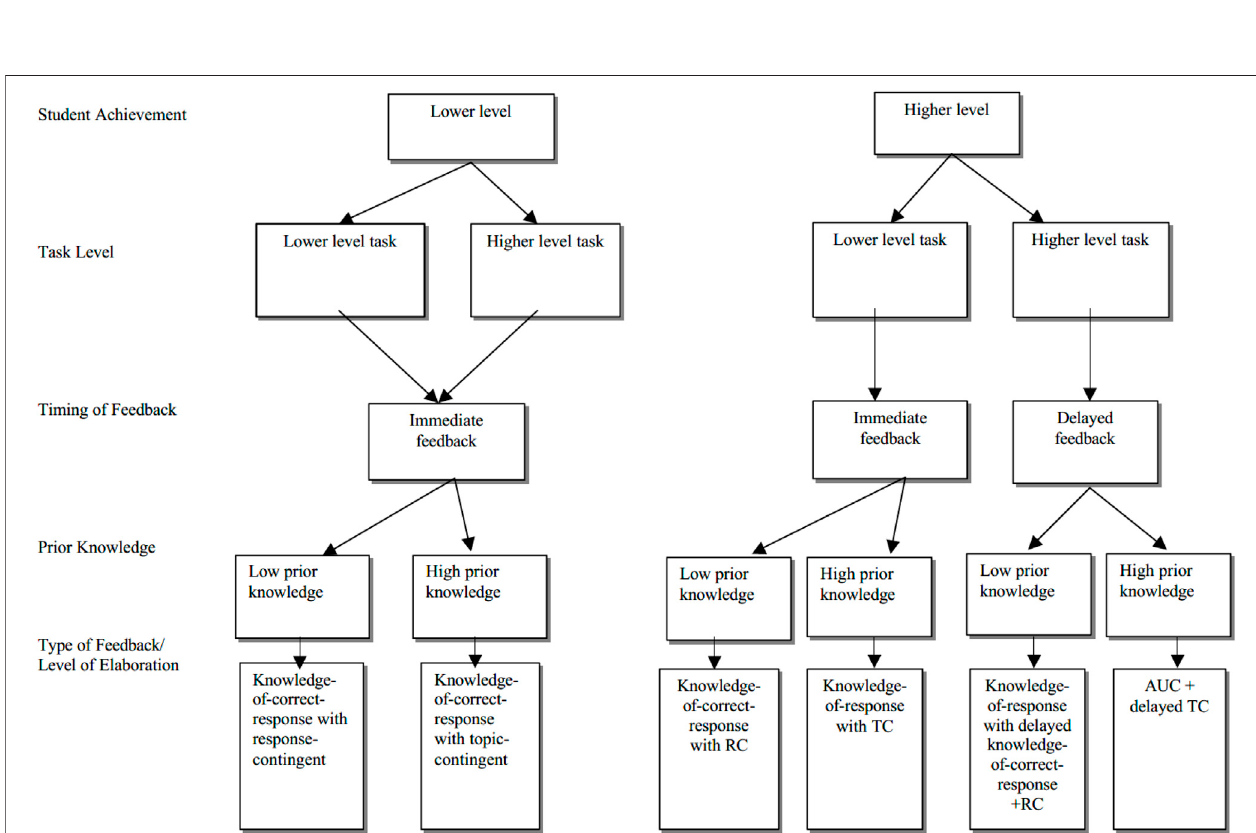
FIGURE 8 | Mason and Bruning (2001)